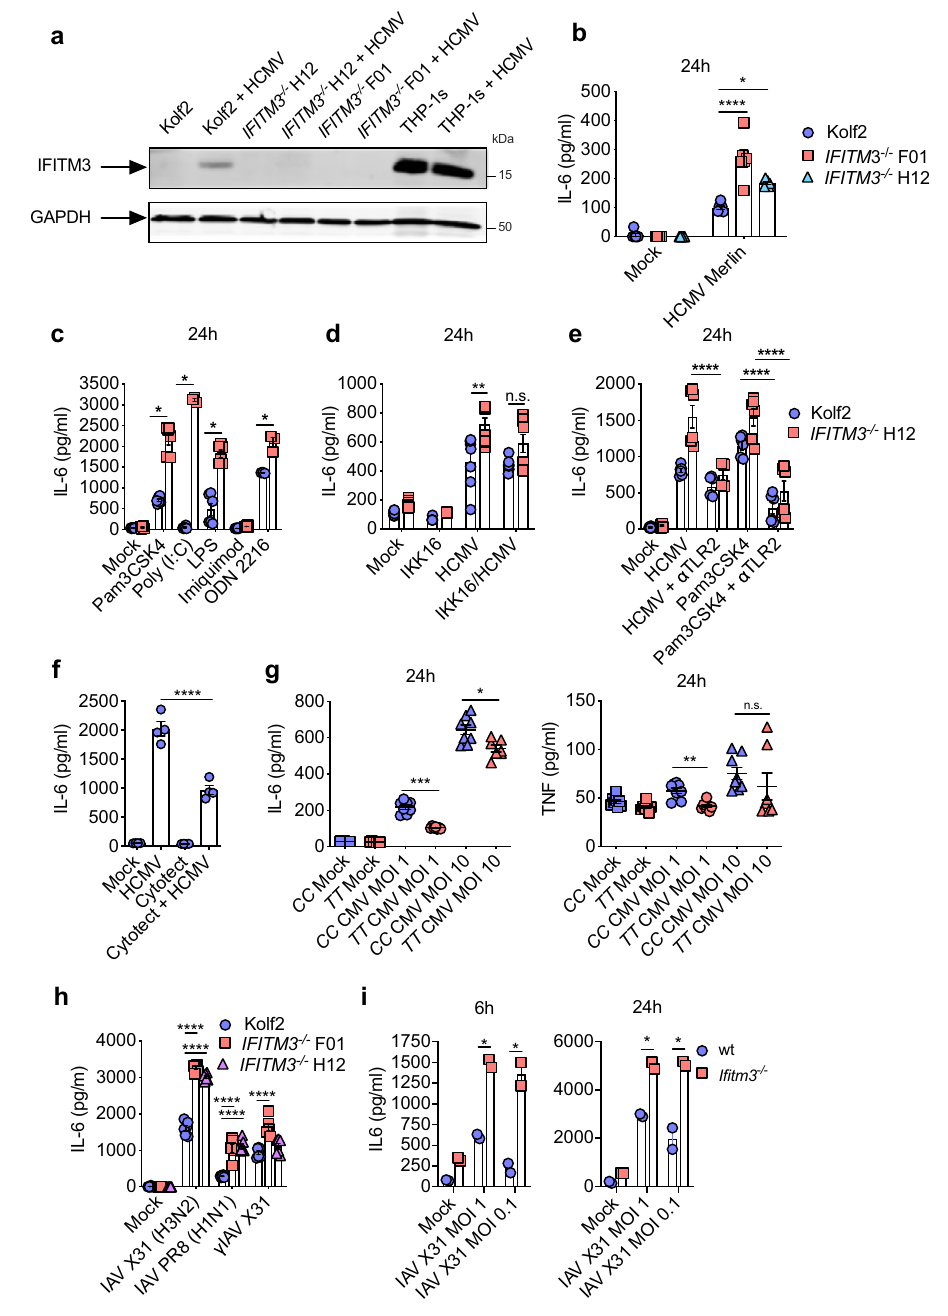
Fig.2|IFITM3regulatesHCMV-andTLR-inducedIL-6inhumanDCs. ELISAdata